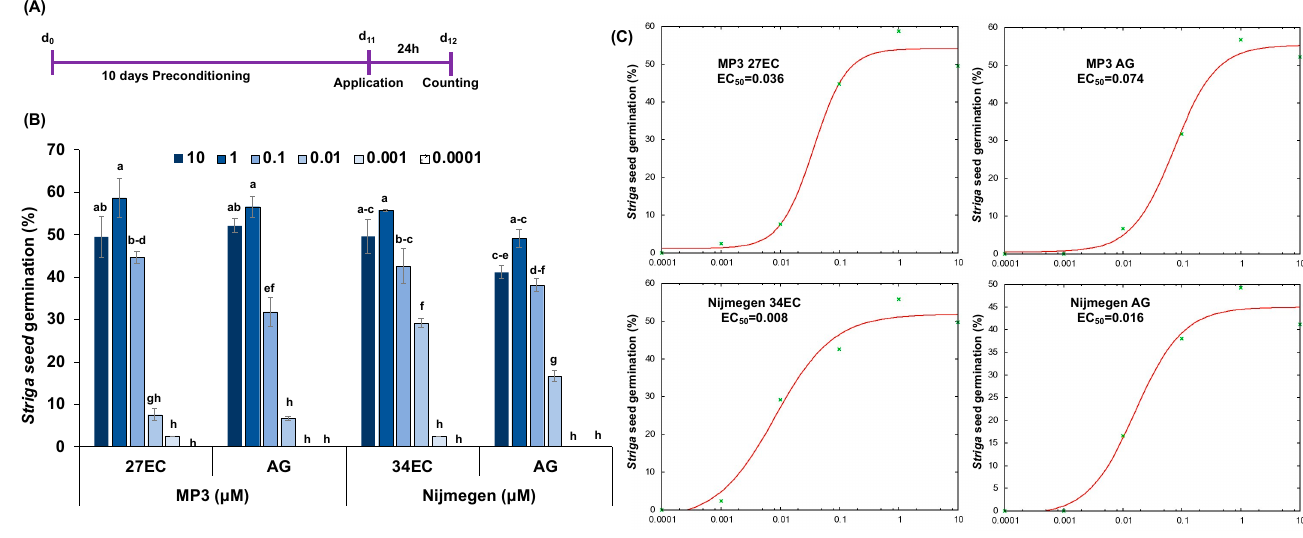
Figure 2. Comparison of EC formulated SL analogs MP3 27EC and Nijmegen 34EC with AG formu- lated SL analogs for Striga seed germination. ( A ) The scheme of the experiment conducted for Striga seed germination bioassays. ( B ) Effect of various concentrations of both formulations (AG and EC) of the two SL analogs on Striga seed germination. The Striga seeds collected from a sorghum infested field during 2020 in Sudan were treated with the two formulations of SL analogs. ( C ) EC 50 of Striga seed germination in response to the various concentrations of the two SL analogs in different formu- lations. Data are means ± SE ( n = 3), treatments with various letters differ significantly according to one-way analysis of variance (ANOVA) and Tukey’s post hoc test ( p < 0.05).